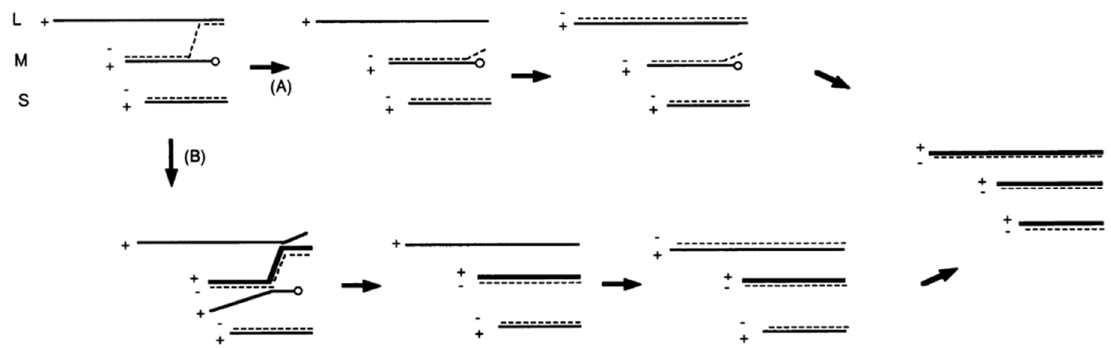
Figure 6. Copy choice model for repair of the M segment. ( A ) The new 3 ′ end is derived from the l segment when it is used as a template, and the continuation of synthesis shifts to the m plus strand.